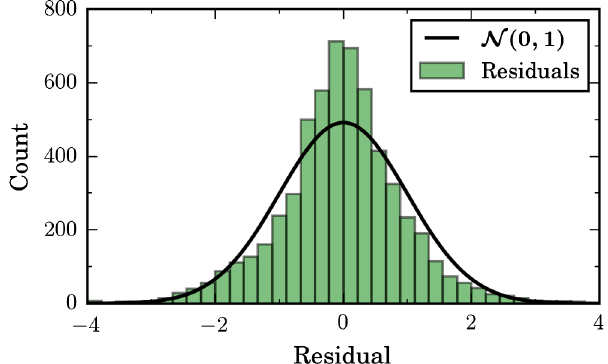
FIG. 2. Residual distribution for the NNLOsim potential, with a sample mean and standard deviation of − 0 . 04 ð 1 Þ and 0.977(9), respectively. The deviations from normality, as discussed in the text, are mainly due to the model error of χ EFT.